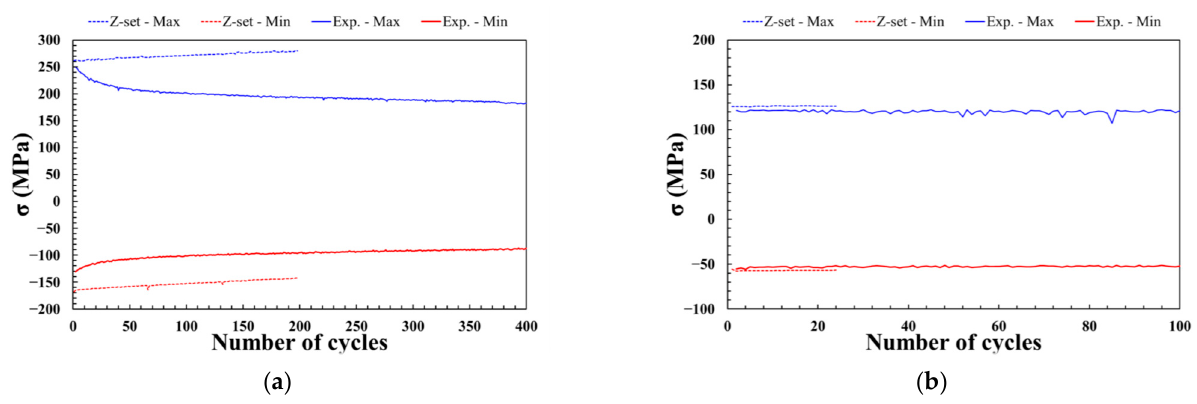
Figure 8. Stress amplitudes according to the number of cycles obtained with LM&C EV EP behavior law in ( a ) T7, and ( b ) T7S conditions by comparison with experimental tests.